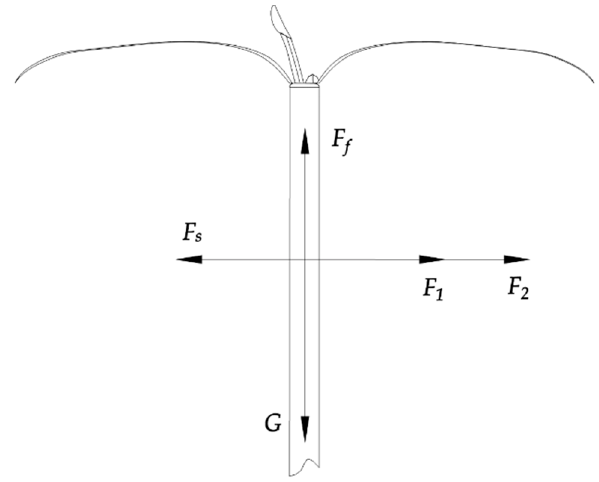
Figure 5. The force diagram of the rootstock stem.